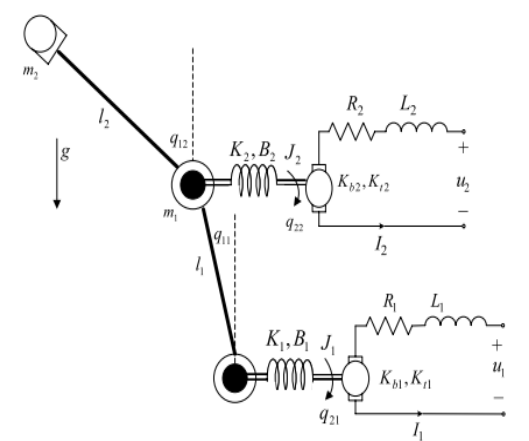
Figure 2. Flexible-joint two-link robot actuated by brushed DC motors [2].